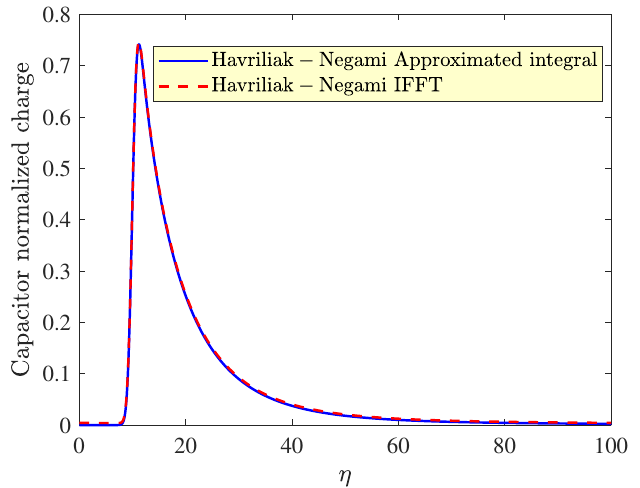
Figure 16. Time-domain comparison for the normalized charge considering the Havriliak–Negami